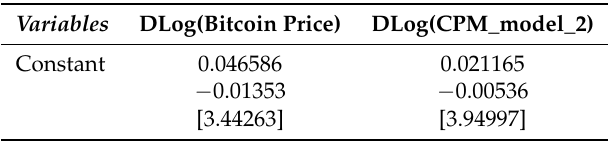
Table A2. VAR(0) for the Log-returns of the pair: Log(Bitcoin price), Log(CPM model 2). First sample: